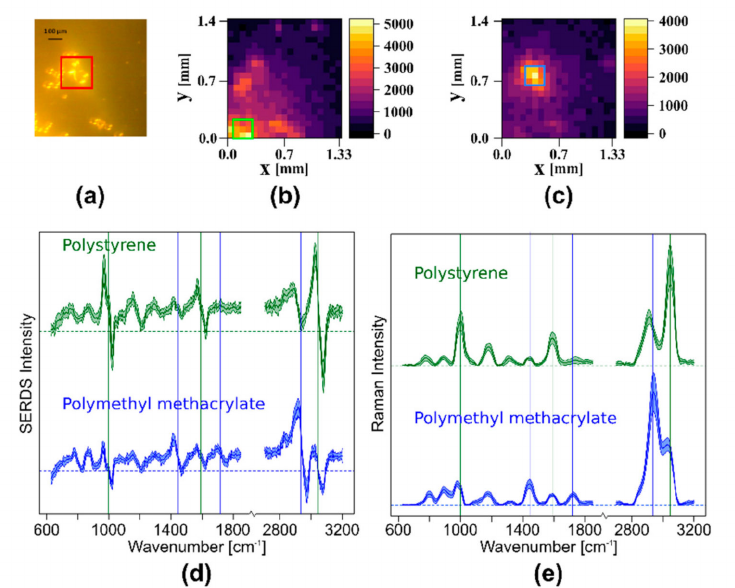
Figure 6. SERDS imaging of polystyrene and polymethyl methacrylate beads: ( a ) bright field image of the sample, red box shows a region of larger PMMA beads; ( b ) PS intensity map based on the intensity of three marker bands in the baseline corrected, reconstructed Raman spectra; ( c ) PMMA intensity map based on the intensity of three marker bands in the baseline corrected, reconstructed Raman spectra; ( d ) mean SERDS spectra and their standard deviation for nine spectra with the highest intensities for PMMA and PS marked by boxes (green for PS, blue for PMMA) in the corresponding intensity maps; ( e ) baseline corrected and reconstructed mean Raman spectra with standard deviation of the SERDS spectra shown in ( d ); The vertical lines in ( d , e ) indicate the marker bands (green for PS; blue for PMMA) that were used to create the intensity maps ( b , c